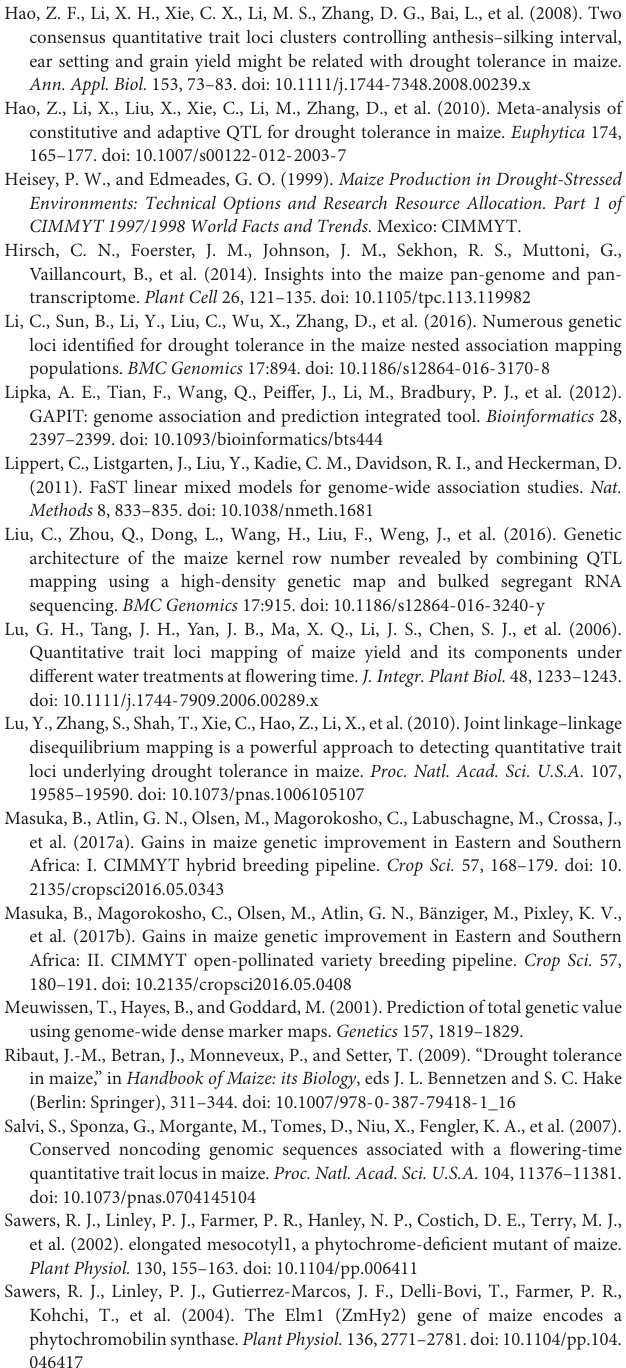
TABLE S3 | The haplotype-based genome-wide association mapping results of the 12 target trait-environment combinations in the DTMA panel. TABLE S4 | The log2 fold-change (WS/WW) of the differentially expressed candidate genes identified in association mapping analysis in four maize lines with different drought